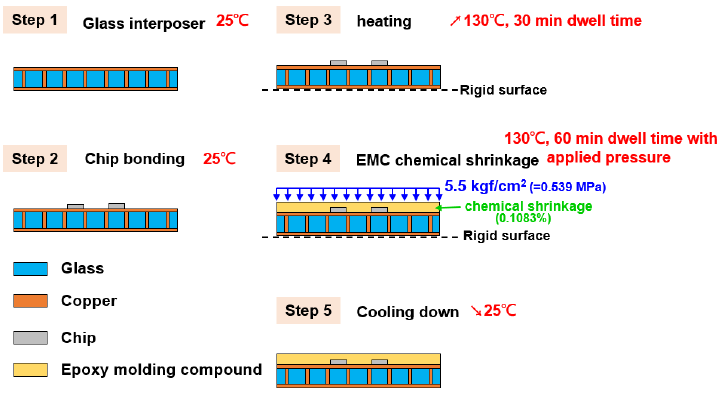
Figure 3. Fabrication process diagram of glass interposer with array-type and process conditions and material components.